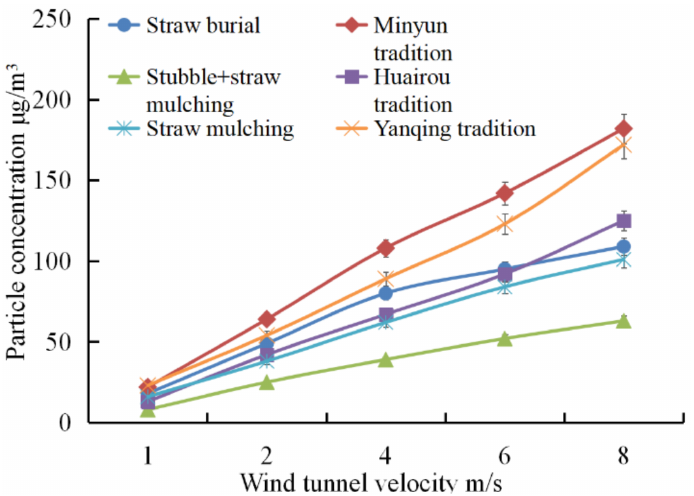
Figure 27. PM2.5 concentration changes with wind speed at 20 cm height in the wind